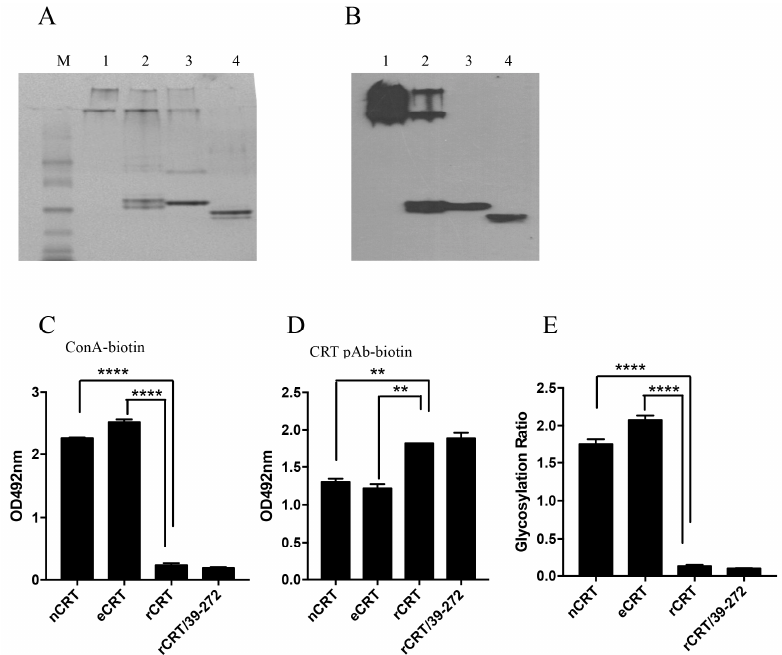
Figure 3. Biochemical properties of eCRT and rCRT. Samples of rCRT/39-272, rCRT, eCRT and nCRT (lanes 1–4, respectively) were compared in Coomassie brilliant blue-stained native PAGE ( A ), followed by WB using rabbit anti-CRT polyclonal antibody for detection ( B ). The secondary Ab was HRP labeled goat-anti-rabbit IgG, with OPD as substrate. ELISA plates were pre-coated with nCRT, eCRT, rCRT or rCRT/39-272 followed by ELISAs using ConA-biotin ( C ) or biotin-conjugated mouse anti-CRT polyclonal antibody ( D ) for detection. The glycosylation ratios of the CRT preparations were calculated as OD ConA /OD pAb ( E ). Results are expressed as mean ± SD of three replicates. **** p < 0.0001; ** p < 0.01. These are representatives of 3 independent experiments.